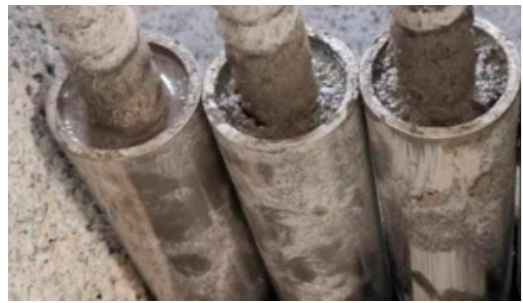
Figure 3. GFRP bars and grouted steel